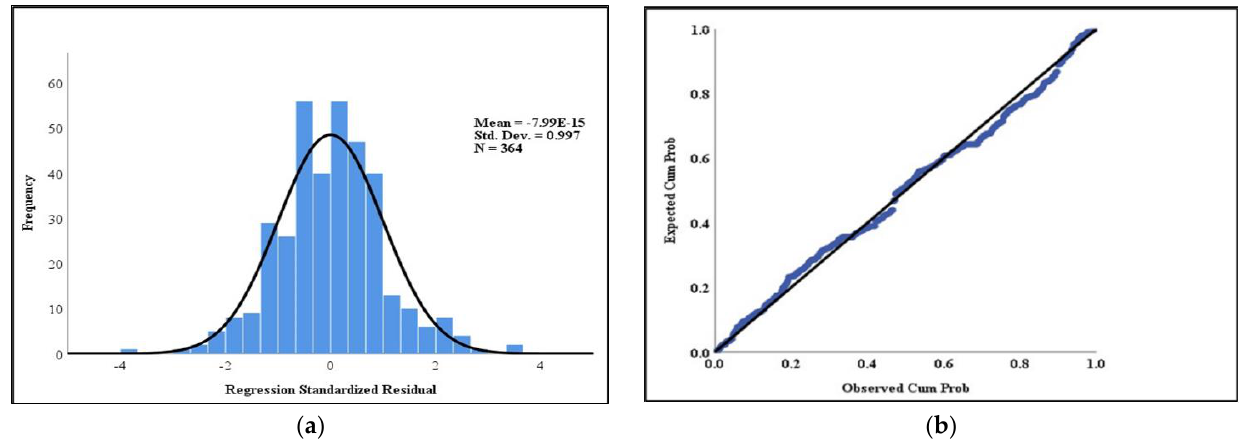
Figure 2. ( a ) Regression standardised residual of independent and dependent variables. ( b ) Normal P – P plot of regression standardised residual.